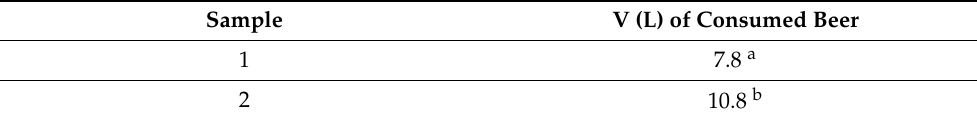
Table 3. Drinkability test results.